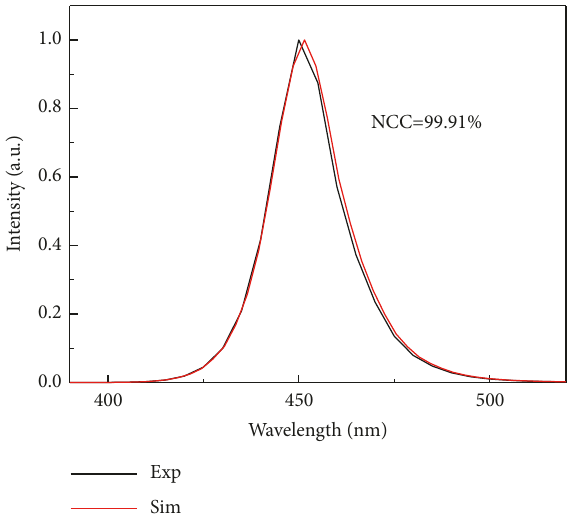
Figure 3: Spectrum of experiment and simulation.